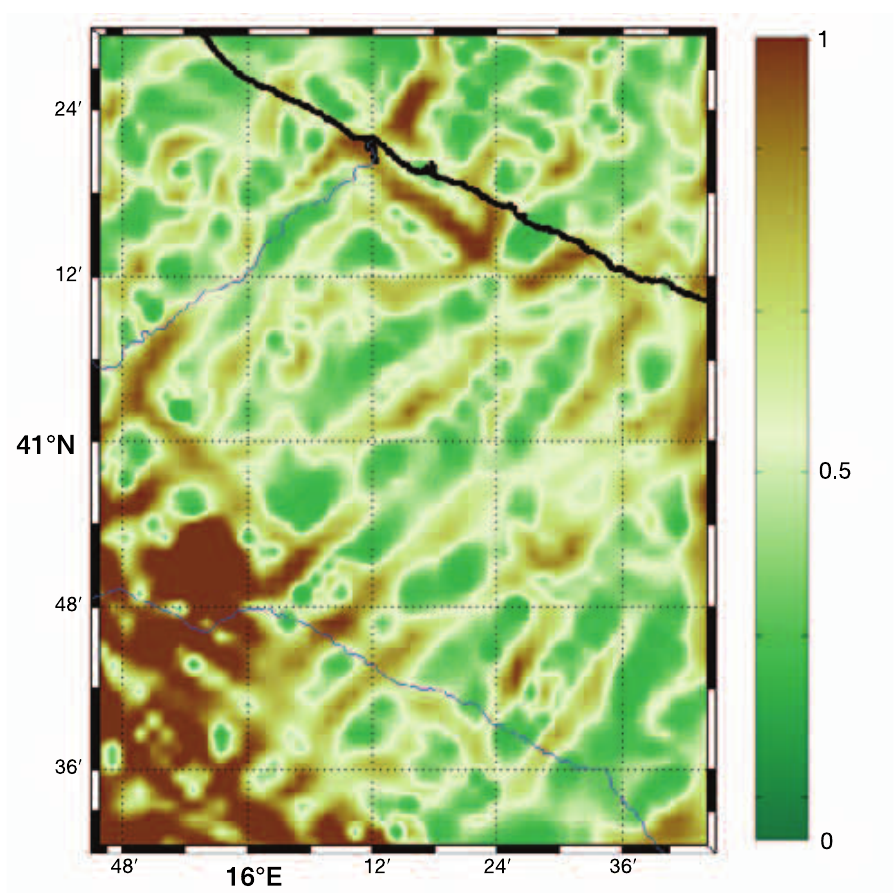
Fig. 6. Short scale MDA map of magnetic data field in the foreland area windowed as shown in fig. 5. Lineaments are represented by trends of maxima, which are graphically recognized by the shown colorbar in normalized